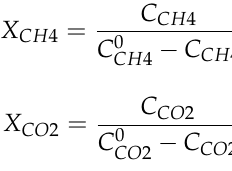
Figure 11. Measured heat effects for the series of the reaction mixture pulses followed by O 2 pulses at 773 K.